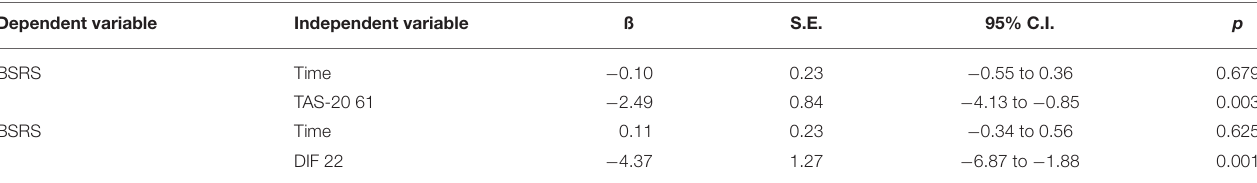
TABLE 4 | Parsimonious generalized equation estimation model of the factors associated with the mental health distress level of healthcare workers. Dependent